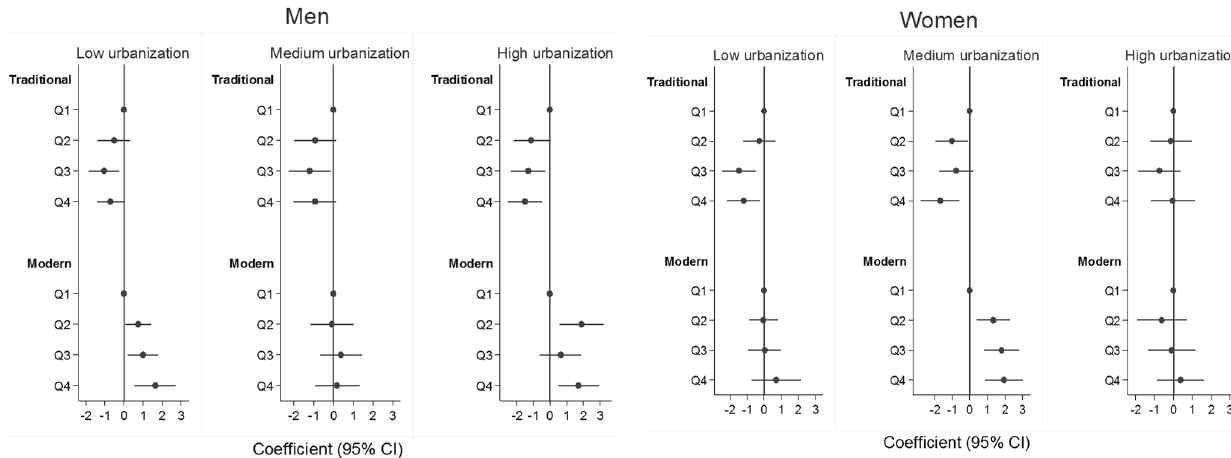
Figure 2. Figure 2. Cont.